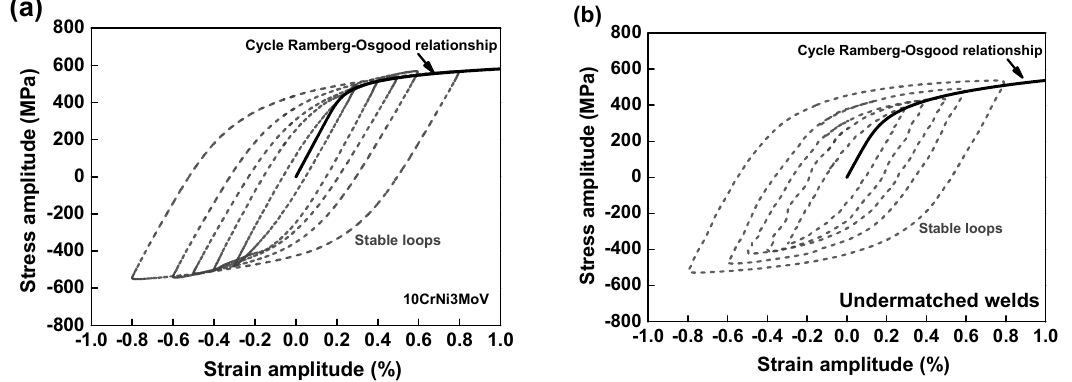
Figure 6. Stabilized stress-strain hysteresis loops and cycle Ramberg-Osgood relationships under different amplitudes: ( a ) 10CrNi3MoV steel; ( b ) Undermatched